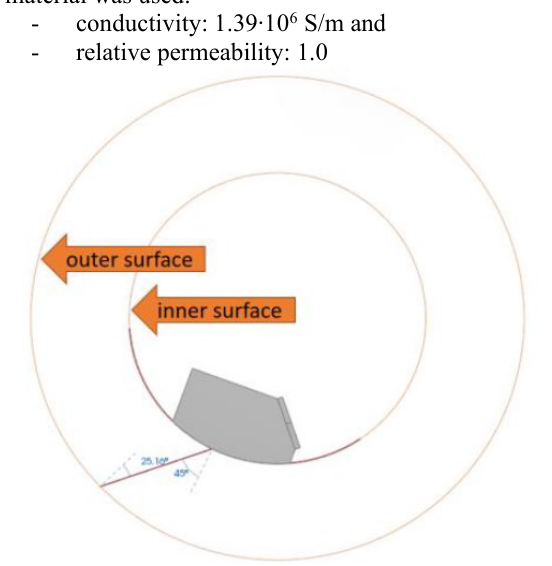
Fig. 2. JHR Storage Pool and Hot Cell.